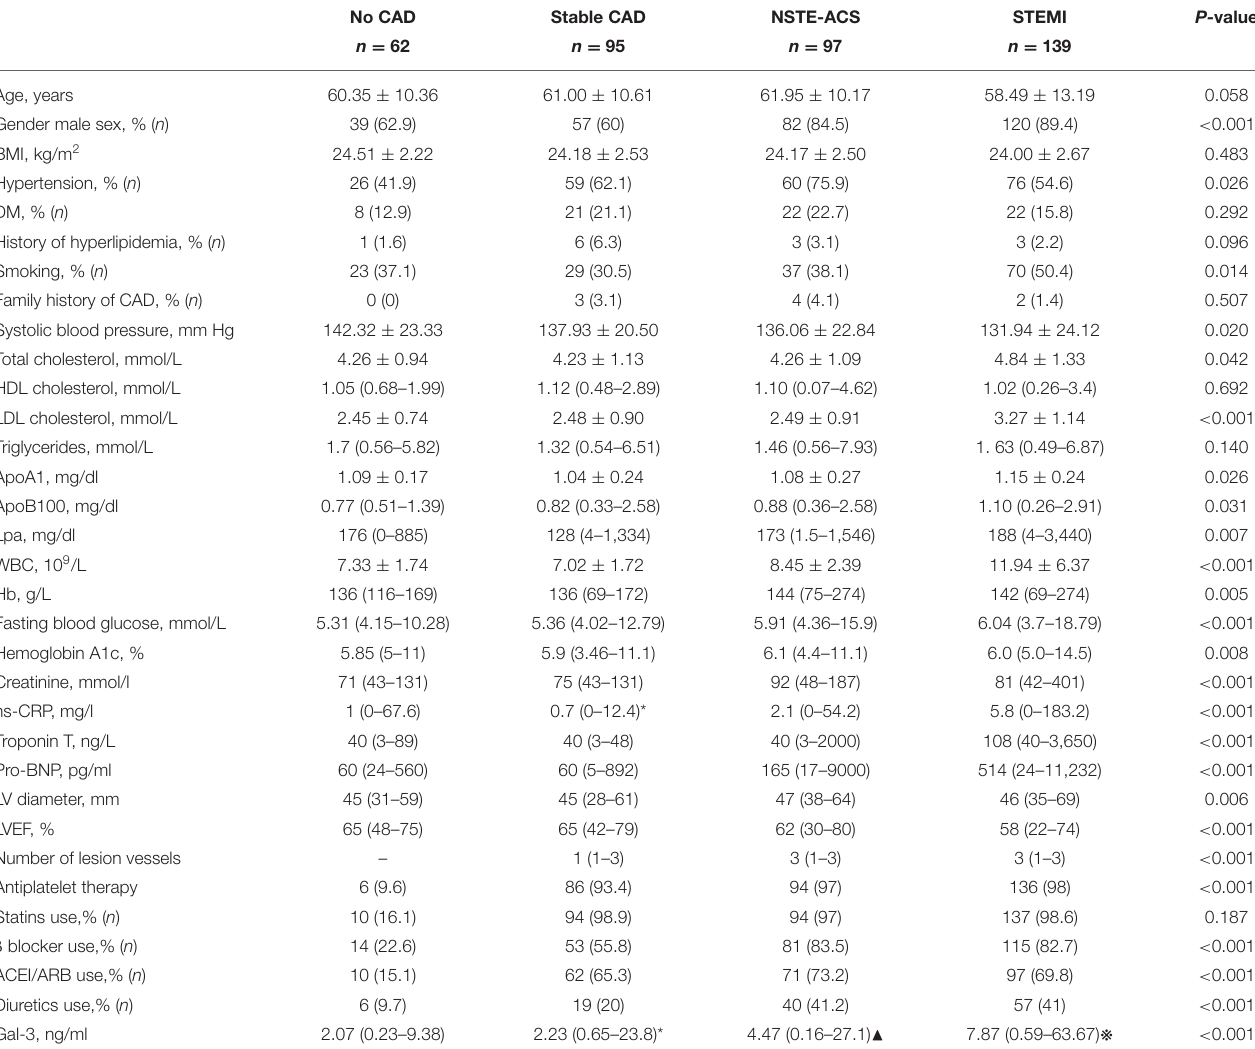
TABLE 3 | The baseline clinical and biochemical characteristics of STEMI vs NSTE-ACS vs Stable CAD vs. non-CAD in the study. No CAD Stable